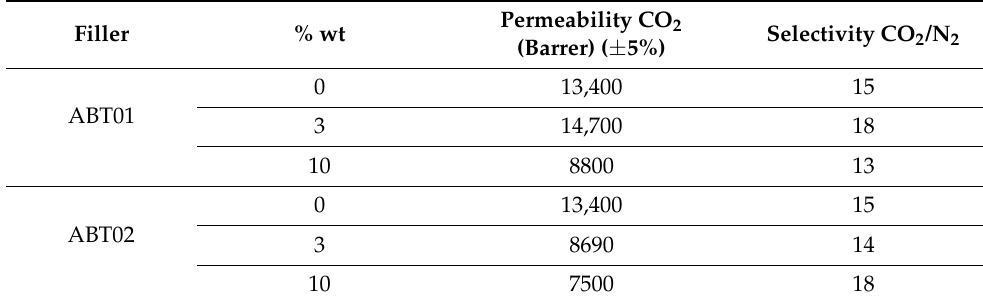
Table 3. Permeation data for PIM-1, PIM-ABT01 (3 and 10% wt), PIM-ABT02 (3% and 10% wt) at t 0